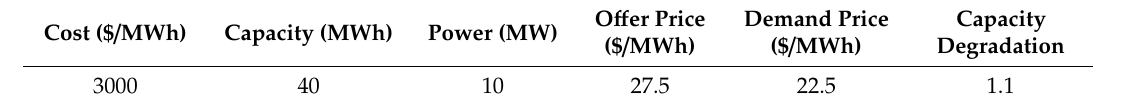
Table 9. Battery characteristics.